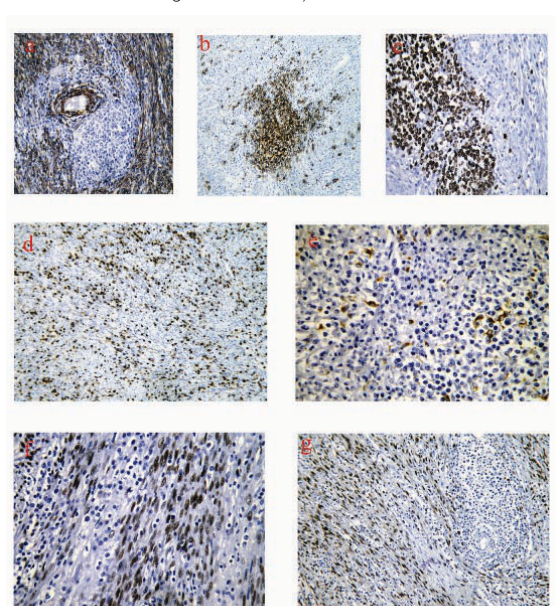
CD3-positive. Few histiocytes (CD68+) were detected (Figure 3). No immunoreactivity for EBV nuclear antigen was observed (data not shown).